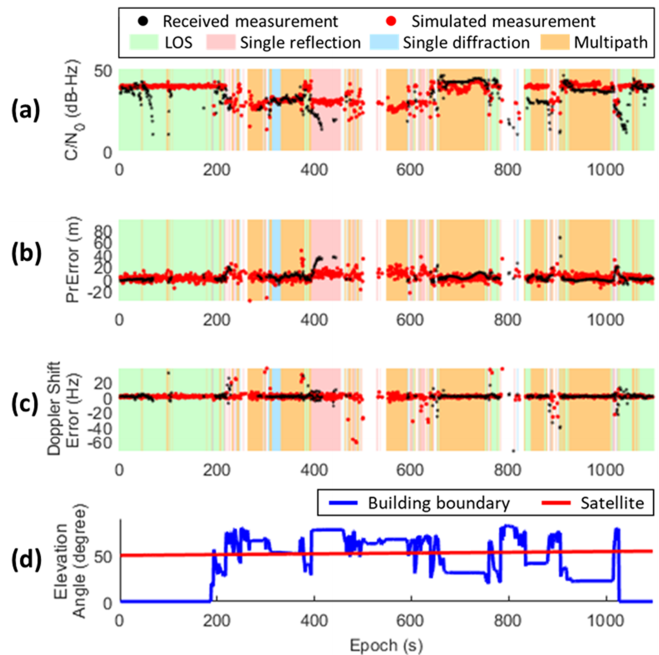
Figure 19. The comparison of the simulated and actual received GNSS measurements from B6 satellite during the dynamic vehicular experiment, including: ( a ) C / N 0 ; ( b ) pseudorange error; ( c ) Doppler shift error; ( d ) the elevation angles of the satellite and the building boundary on the satellite’s azimuth The overall positioning solutions and corresponding errors from simulation and real measurements are shown in Figure 20. The proposed simulator appropriately simulates the increment of positioning error when entering a dense urban area, and the recovery of positioning accuracy when back to an open-sky environment. The positioning perfor- mance based on simulation behaves similar to that based on real measurements, except the beginning and ending periods. As mentioned before, the vehicle is nearby a construct- ing building without a model in the beginning period. Hence, the measurement errors from that building are underestimated, leading to a much smaller positioning error from the simulation. The second inconsistent period is probably because the vehicle is nearby the building with a complicated (ship-like) structure. The ray-tracing algorithm based on the LoD-1 building model cannot comprehensively predict all the valid interfered signals related to this building. As a result, the corresponding GNSS measurement error and the positioning error are underestimated. In summary, the proposed simulator can realisti- cally simulate the GNSS measurement and positioning behavior of a vehicular agent in the urban area.